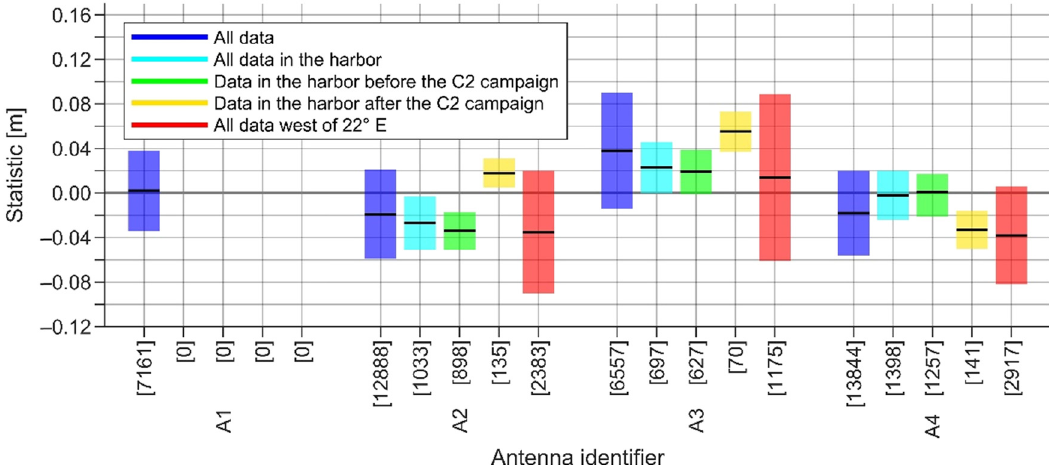
Figure 9: Statistical properties of di ff erences between CSRS - PPP and TBC height solutions in fi ve cases ( see the legend ) . The black lines are mean di ff erences, and colored bars denote standard deviation estimates. The total number of data points considered in comparisons can be found in square